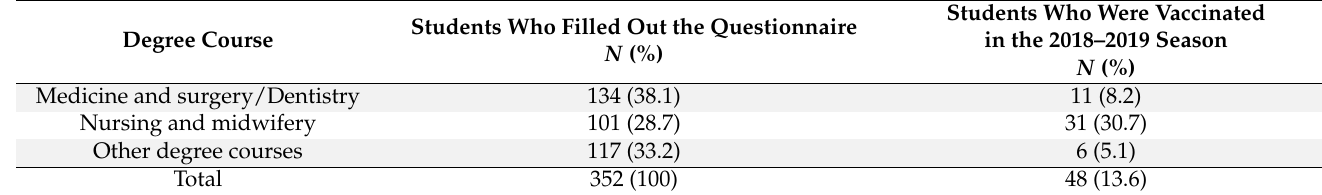
Table 1. Distribution of participants and students who were